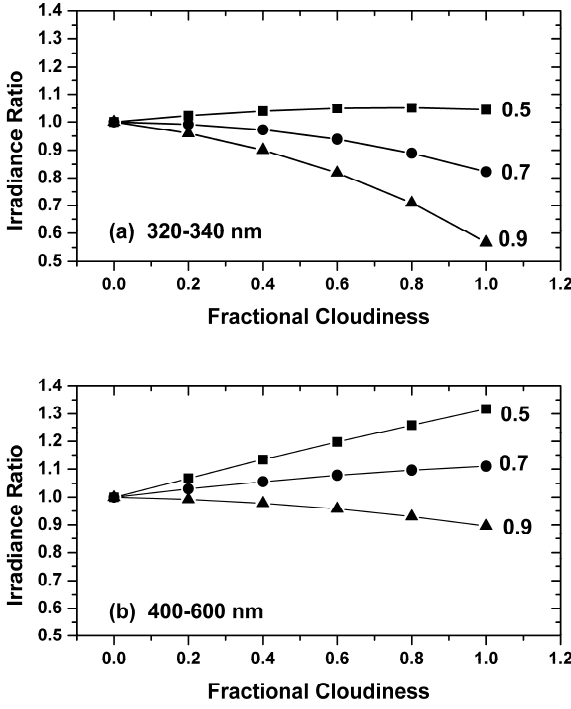
Fig. 8. Computed irradiance ratios as functions of fractional cloudi- ness for cloud albedos of A c =0.5, 0.7 and 0 . 9. The solar disk is not obscured by clouds, and the ground albedo is A G = 0 . 0. (a) 320– 340nm wavelength band. (b) 400–600nm wavelength band.